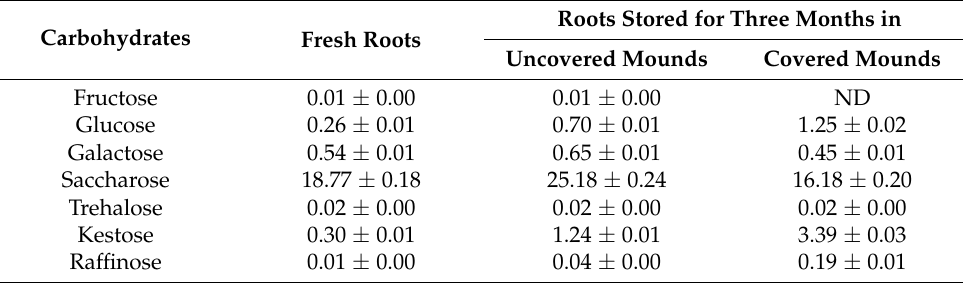
Table 1. The content of free carbohydrates in sugar beet roots (% w / w ). Roots Stored for Three Months in Carbohydrates Fresh Roots Uncovered Mounds Covered